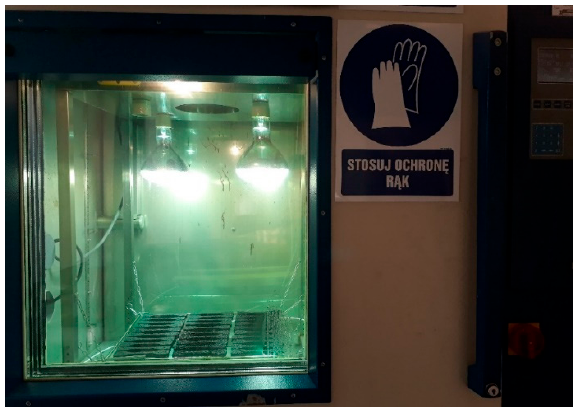
Figure 10. Samples of the elastomeric material in the climatic chamber Feutron, simulating high temperature and solar radiation.